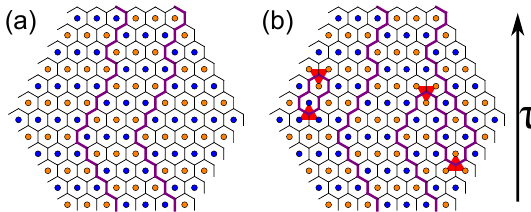
Figure 2: Mapping between Ising configurations on the triangular lattice and string configurations on the dual honeycomb lattice. (a) In the absence of defect triangles, strings (purple) wind the system. (b) Defect triangles (red) act as sources and sinks of pairs of strings, allowing strings to turn back on themselves and form short closed loops. By choosing one of the spatial directions as imaginary time, τ , the strings can be interpreted as the worldlines of fermions, with defect triangles corresponding to pair creation or